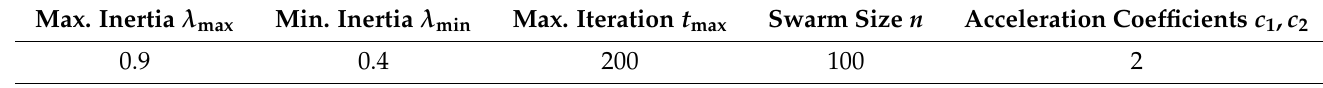
Table 1. Parameterization of the